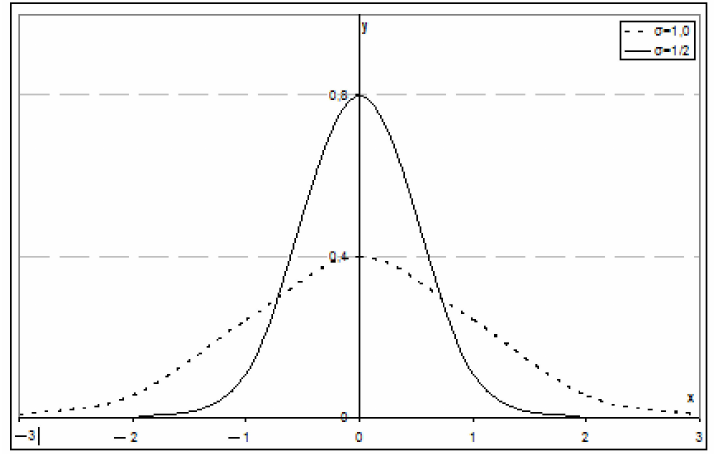
Figure 6. The Gaussian distribution density of the normalized random variable y = θ ( u ) , where x = u = ( δ i – ξ )/( ξ · σ ), with the centre ξ and dispersion σ 2 . Standard deviation clearly defines Function (6) and the values u =1 and u = − 1 correspond to inflection points on a curve plotted according to the dependence (6).